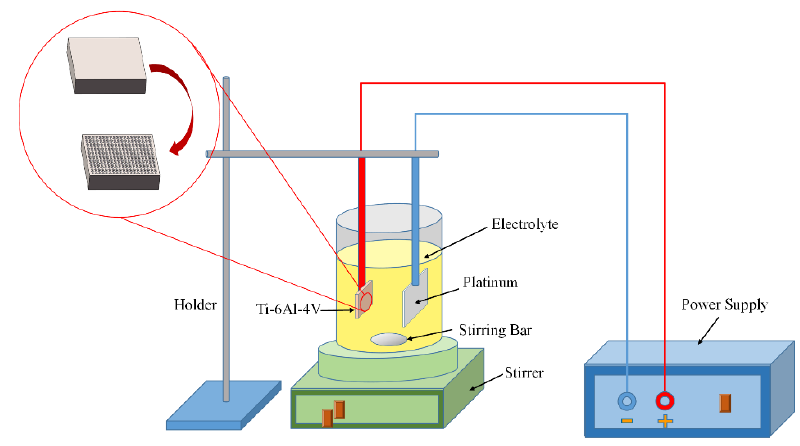
Figure 2. Diagram of anodic oxidation.